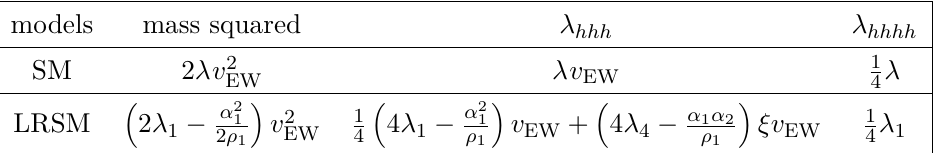
Table 3 . Comparison of the masses squared, trilinear and quartic couplings of the SM-like Higgs h in the SM and LRSM [105,